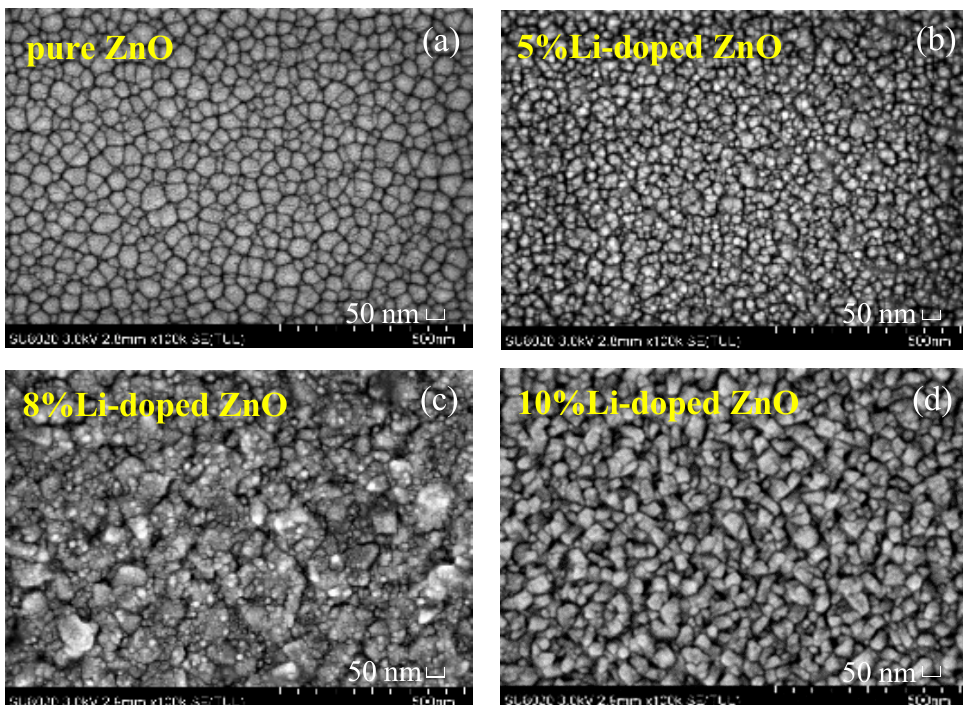
Figure 3. The SEMs of pure and Li-doping ZnO films on the Pt/Ti/SiO 2 /Si substrates: ( a ) pure; ( b ) 5%; ( c ) 8%; ( d ) 10%.